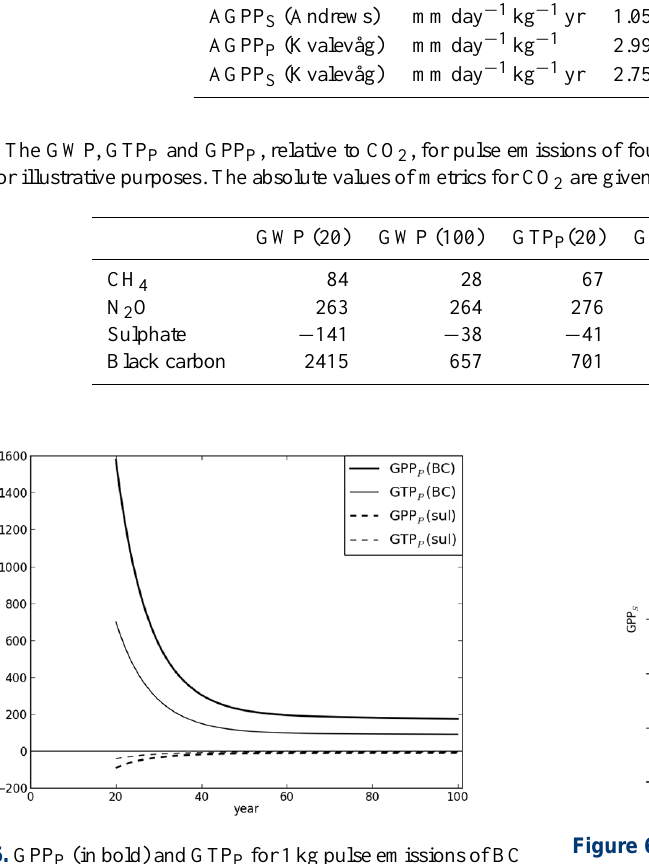
Figure 5. GPP P (in bold) and GTP P for 1kg pulse emissions of BC and sulphate relative to a 1kg pulse emission of CO 2 .